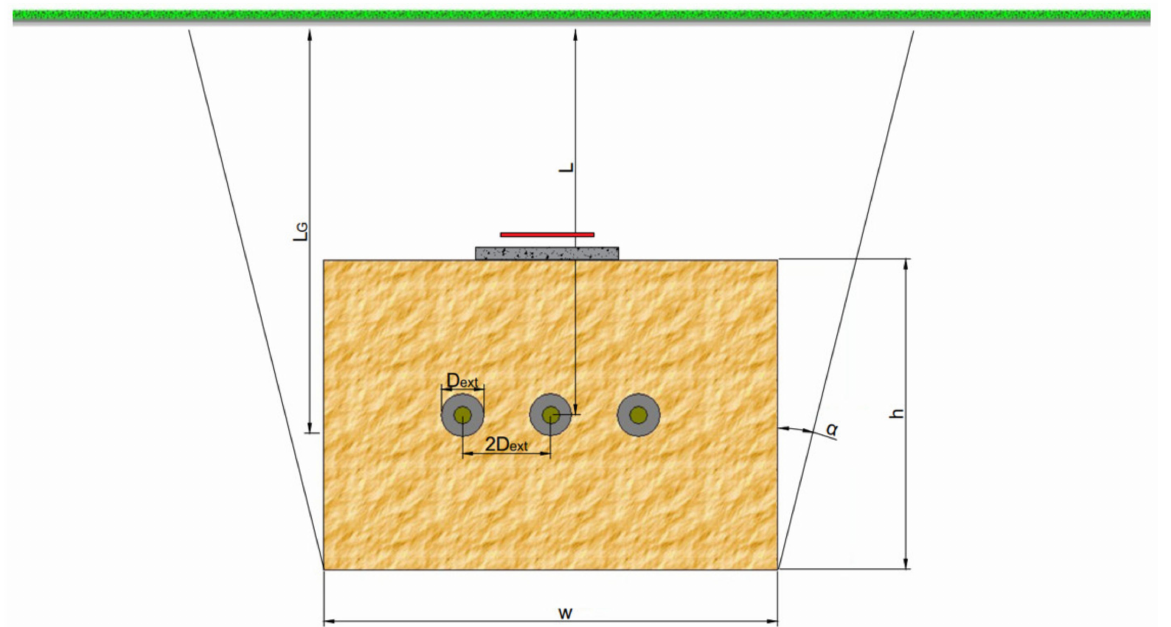
Figure 1. Cables in flat formation with spacing, placed in a backfill; L —distance from the ground surface to the cable center, mm; h —height of the backfill, mm; w —width of the backfill, mm; D ext —axial spacing of the adjacent cables, mm; α —angle of the excavation trench, ( ◦ ).